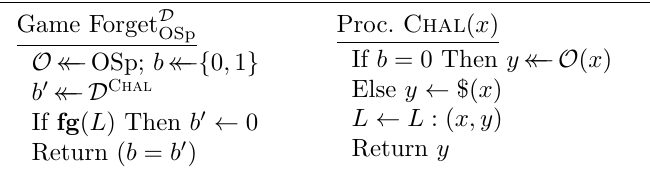
Figure 5: Game defining forgetful switching